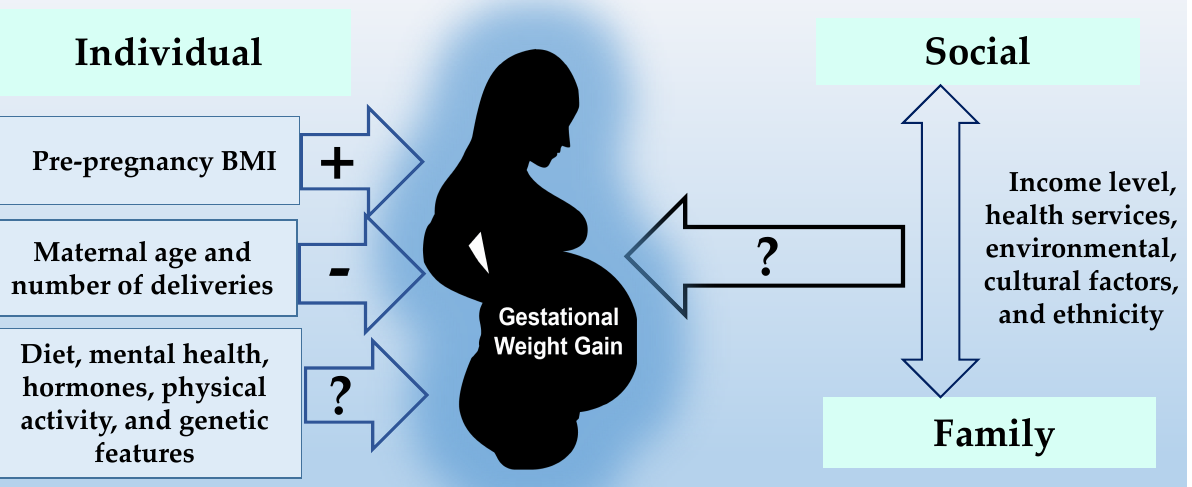
Figure 2. Factors associated with gestational weight gain in pregnant adolescents. Association: (+) positive, ( − ): negative, (?): adolescent.